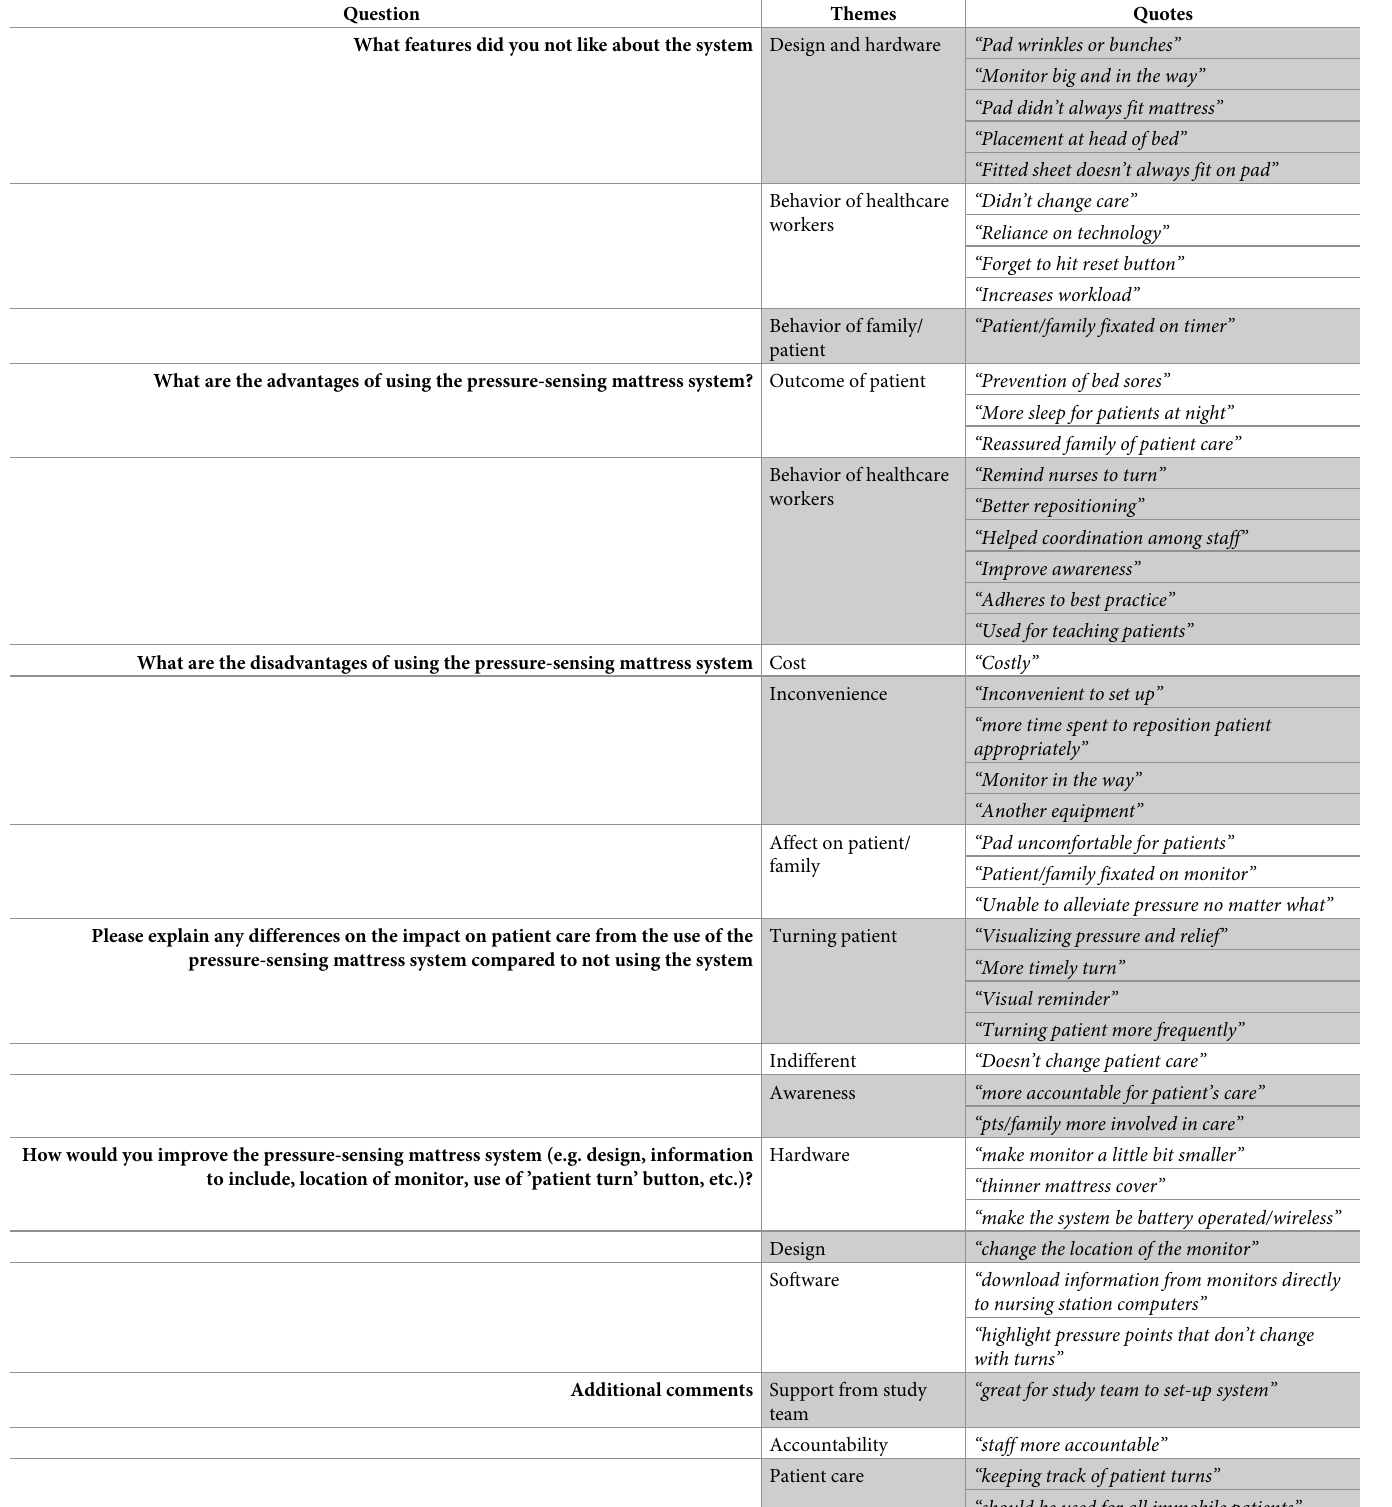
Table 2. Responses to open-ended questions of healthcare provider